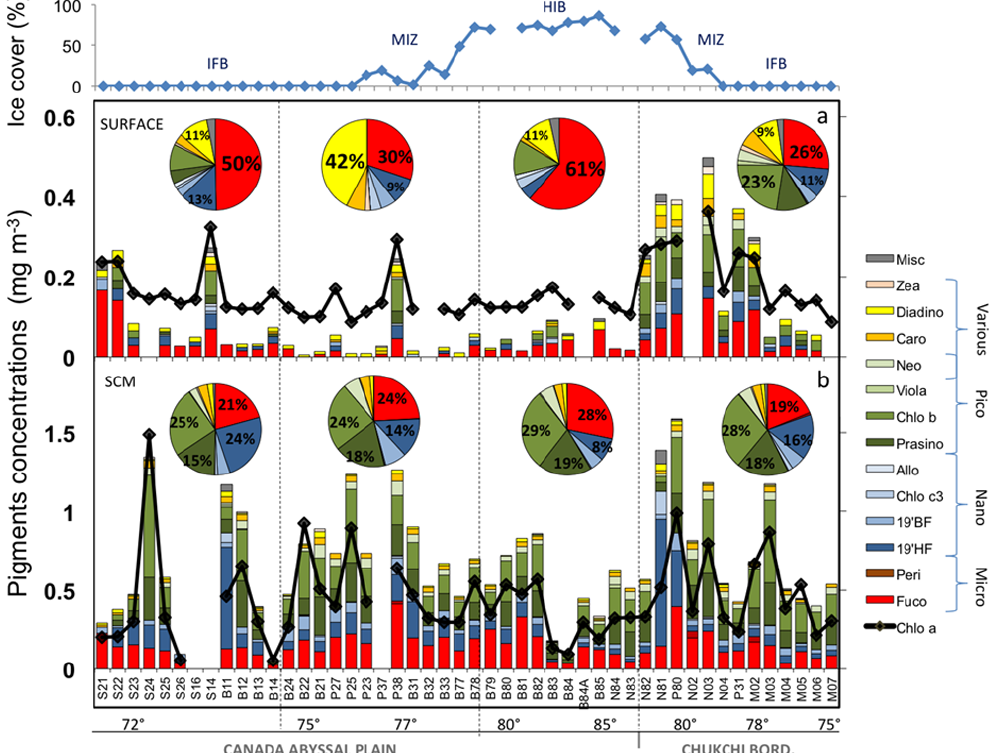
Fig. 3. Concentrations of Chlorophyll a (Chl a) and major accessory phytoplankton pigment concentrations (in mgm − 3 ) (Table 1 for pigment acronyms) over the Chukchi Borderland and the Canada Abyssal Plain in (a) surface waters and (b) in the SCM. The miscellaneous group (Misc) refers to pigments present in proportions < 2%, i.e., Chl c 2, Diato, Lut, DVchla. The pie charts show the average relative proportions of the major accessory